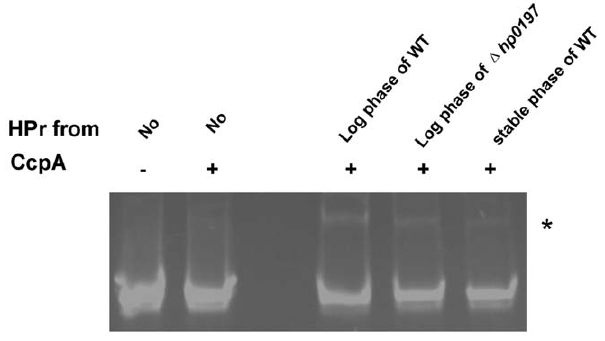
Figure 5. hp0197 controls CcpA activity by HPr-Ser-46P. The purified FLAG-tagged HPr from the log-phase WT or D hp0197 bacteria were compared to evaluate the binding of CcpA to its target site ( cre ) by EMSA. The HPr from the stable-phase WT strain served as a control. Significant more DNA (indicated by *) with CcpA and HPr from Log- phase WT migrated slower than DNA with CcpA and HPr from D hp0197 or from the stable-phase WT strain, indicating that HPr from log-phase WT could enhance the binding of CcpA to cre and the HPr from log- phase D hp0197 could not enhance the ability significantly.